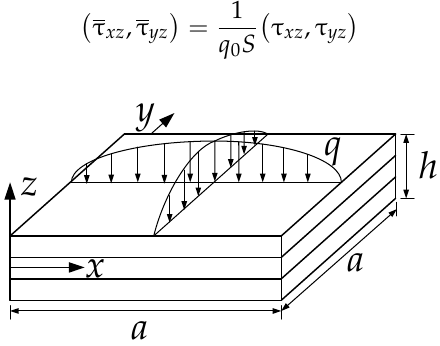
Figure 2. Square laminated plate subjected sinusoidally distributed transverse load.